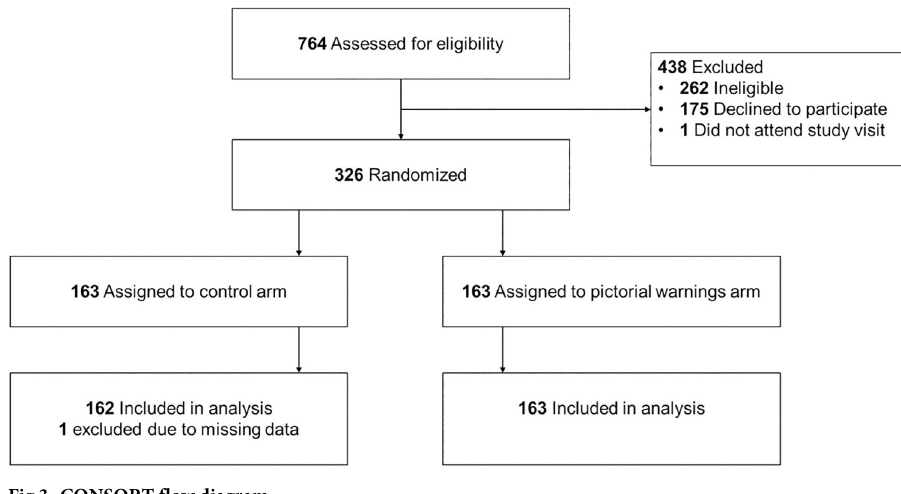
Fig 3. CONSORT flow